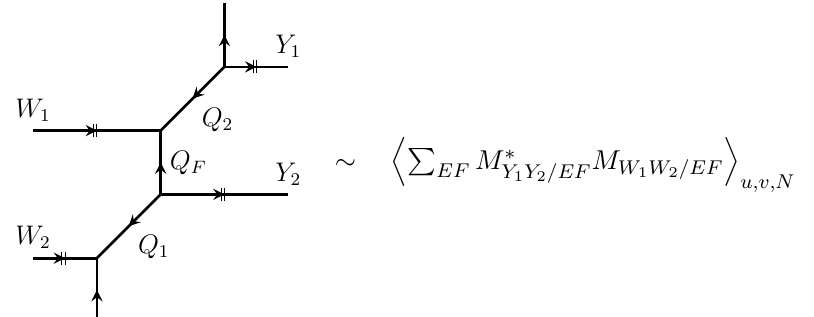
Figure 2 . Re(cid:12)ned topological string amplitude giving the q -Selberg average of two skew generalized Macdonald polynomials. The number of integrations N and the parameters of the integral u; v are expressed through the K(cid:127)ahler parameters Q 1 ; 2 and Q F according to eq.